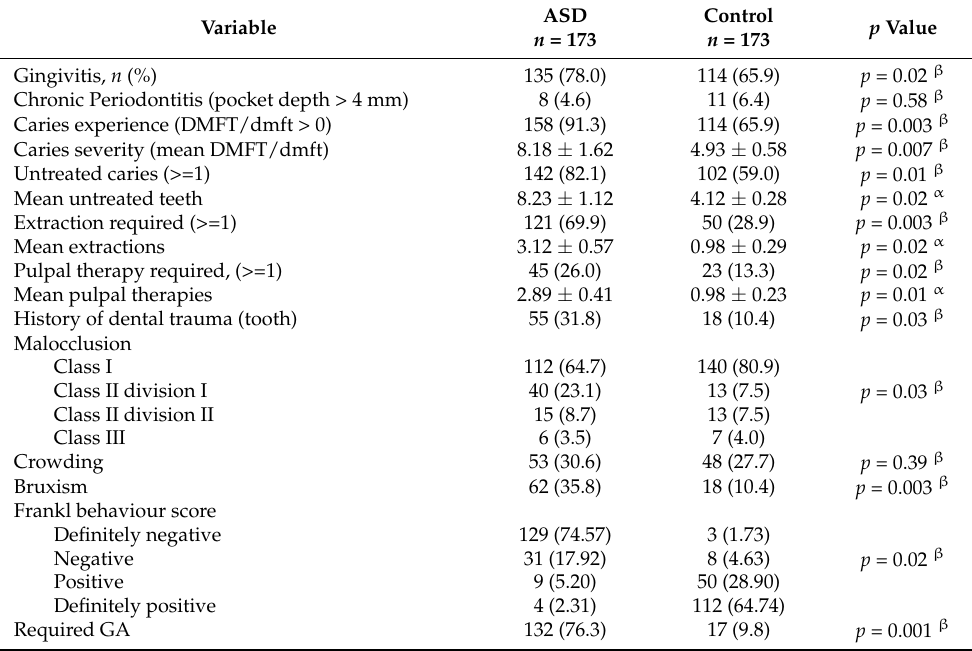
Table 2. Clinical characteristics of the study population, n (%) or mean ± (SD).